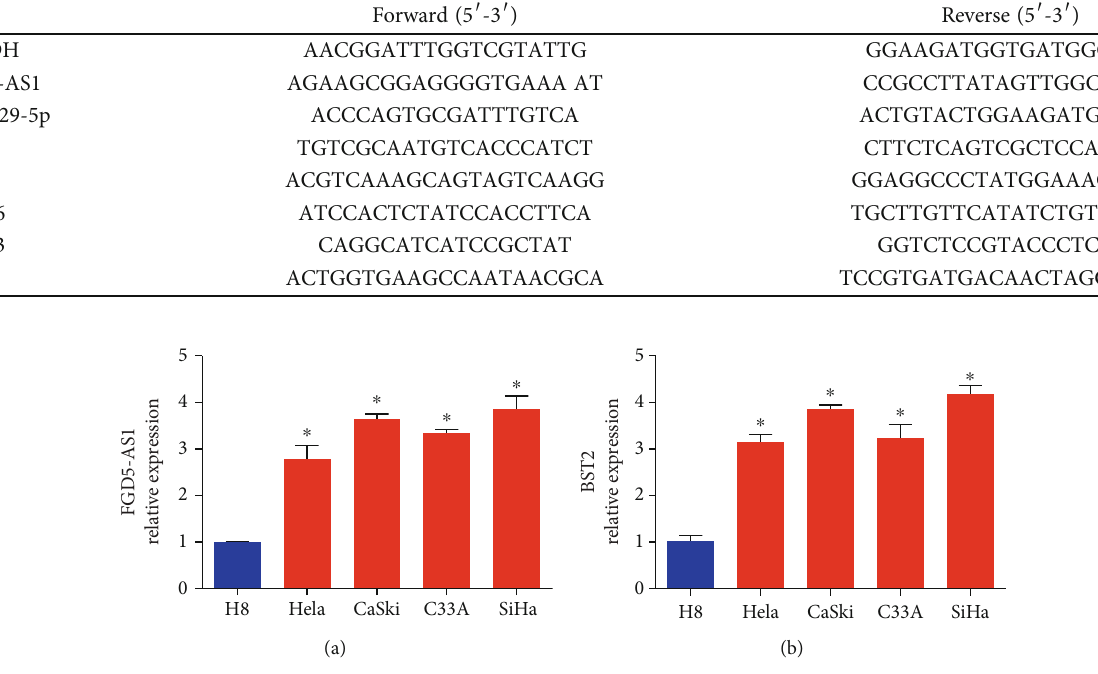
Figure 1: FGD5-AS1 and BST2 expression in cervical cancer cells. (a) RNA levels of FGD5-AS1 in HeLa, SiHa, C33A, CasKi, and H8 cells. (b) RNA levels of BST2 in HeLa, SiHa, C33A, CasKi, and H8 cells. ∗∗∗ P < 0 : 001 and ∗ P < 0 : 05 . Three independent assays were carried